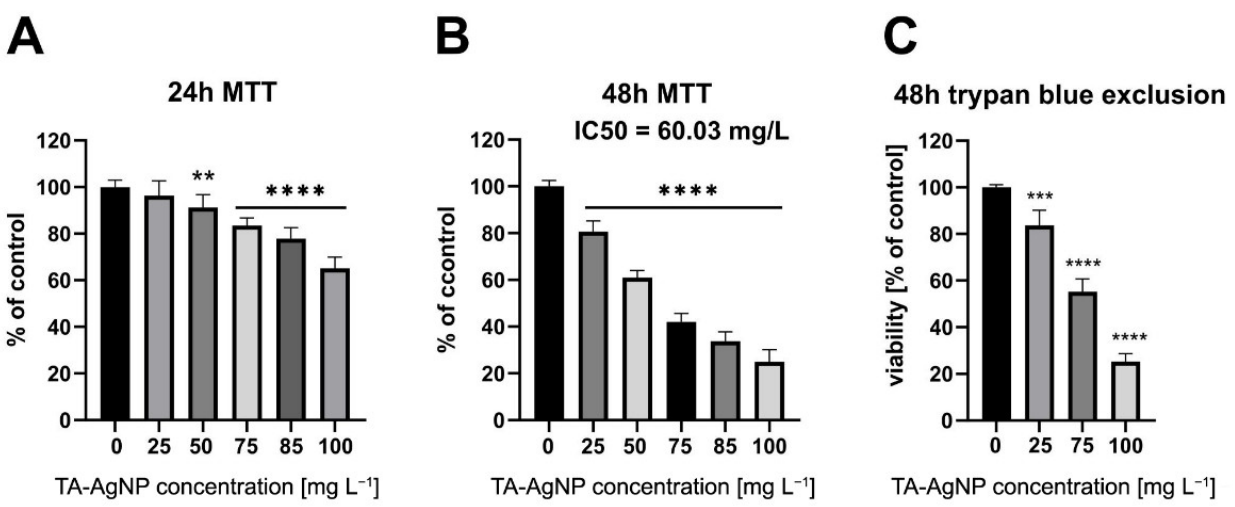
Figure 5. Cell viability of human primary nasal epithelial cells. ( A ) MTT assay following exposure of cells to TA-AgNPs at the indicated concentrations for 24 h. ( B ) MTT assay following exposure of cells to TA-AgNPs at the indicated concentrations for 48 h. Data represent mean values of three independent experiments performed in triplicate ( n = 9), expressed as % of control ± S.D. * indicates values significantly different from the control, i.e., MTT assay for 0 mg L −1 of TA-AgNP. ( C ) Trypan blue exclusion assay. The percentage of viable cells was determined after a 48 h incubation in the presence of TA-AgNPs. Data represent mean values ± S.D. Statistical significance compared to the control assays at 0 mg L −1 of TA-AgNP. Levels of statistical significance: ** p ≤ 0.01; *** p ≤ 0.001; **** p ≤ 0.0001.